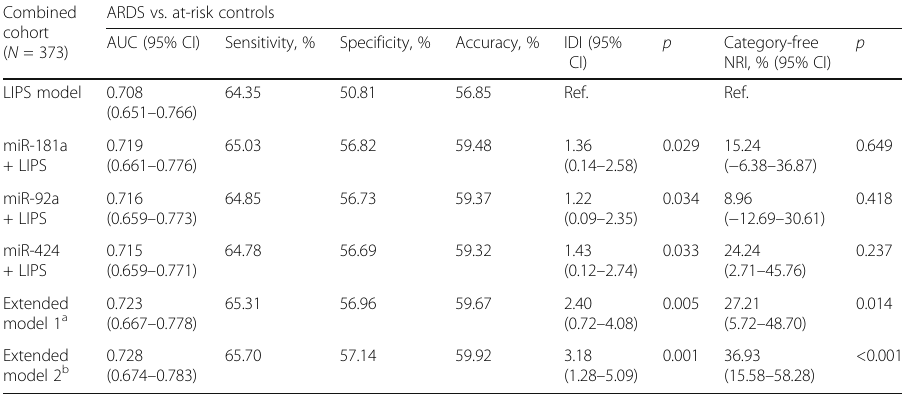
Table 4 Diagnostic performance of sepsis/pneumonia model and miRNA combined model for